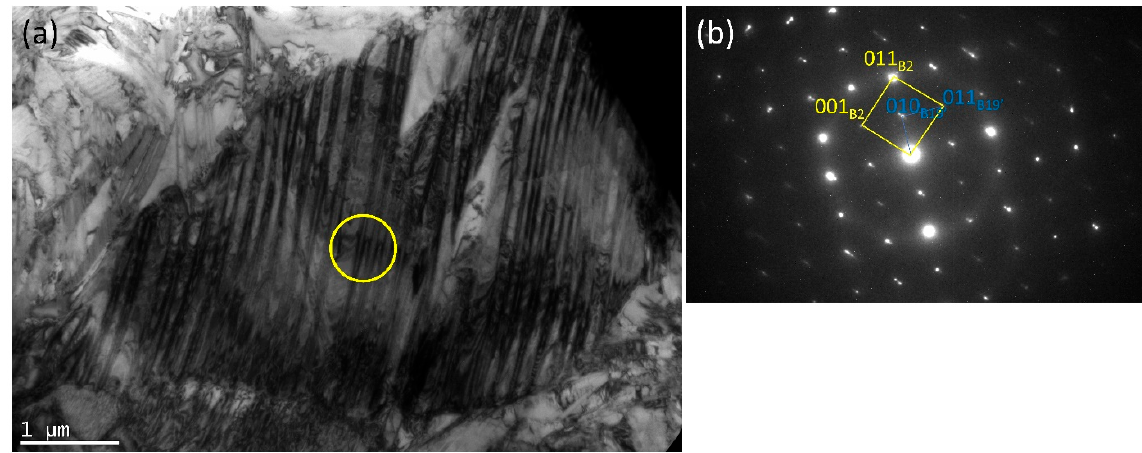
Figure 6. DTA trace of HT2 (900 ◦ C/24 h) sample shows that NiTi 2 melts at about 1128 ◦ C and solidifies during cooling at about 1113 ◦ C.